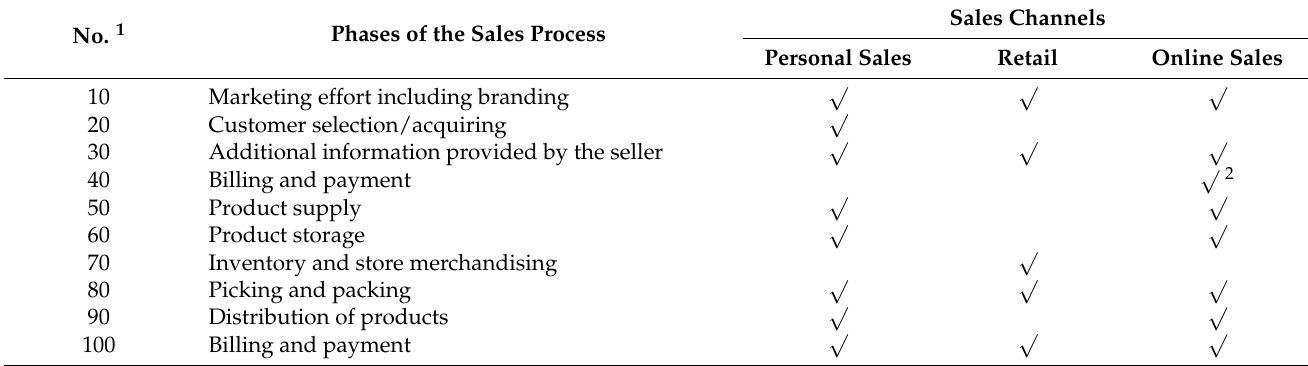
Table 4. Inclusion of sales process phases in sales channels.